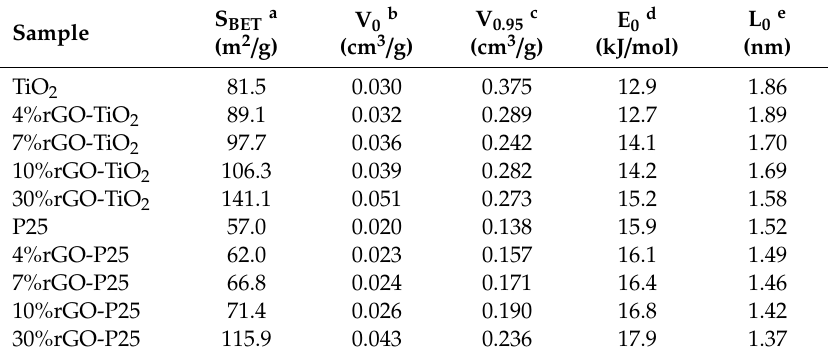
Table 1. Textural characteristics of rGO-TiO 2 and rGO-P25